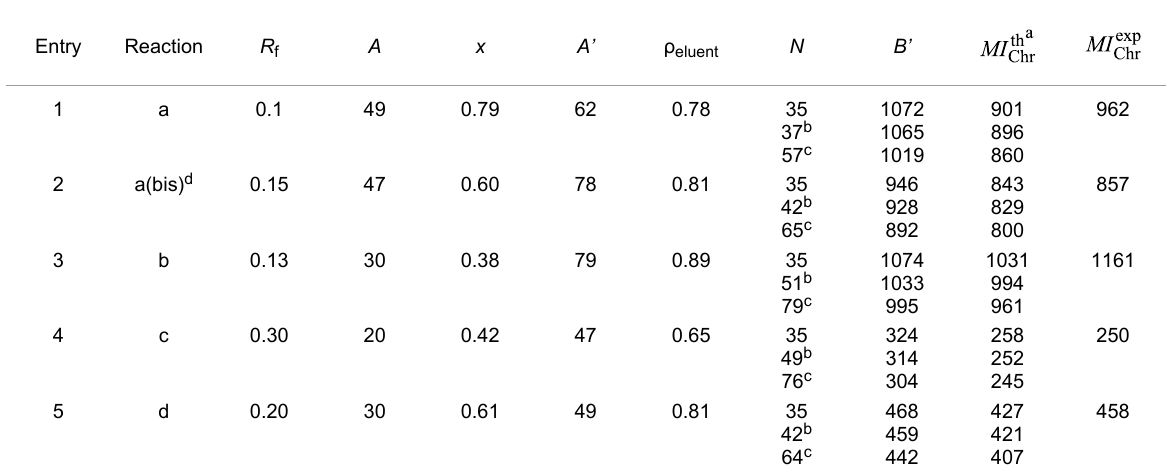
Table 2: Comparison of the experimental values of the mass intensity of chromatography ( ) with the theoretical estimated values ( ) for various reactions (Scheme 1).